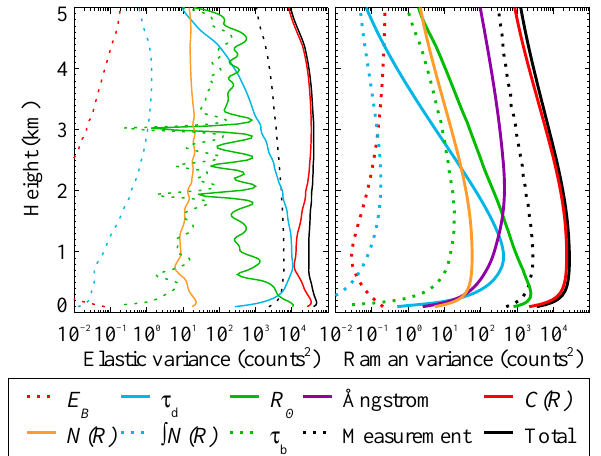
Fig. 11. The contributions of model parameters to the total retrieved